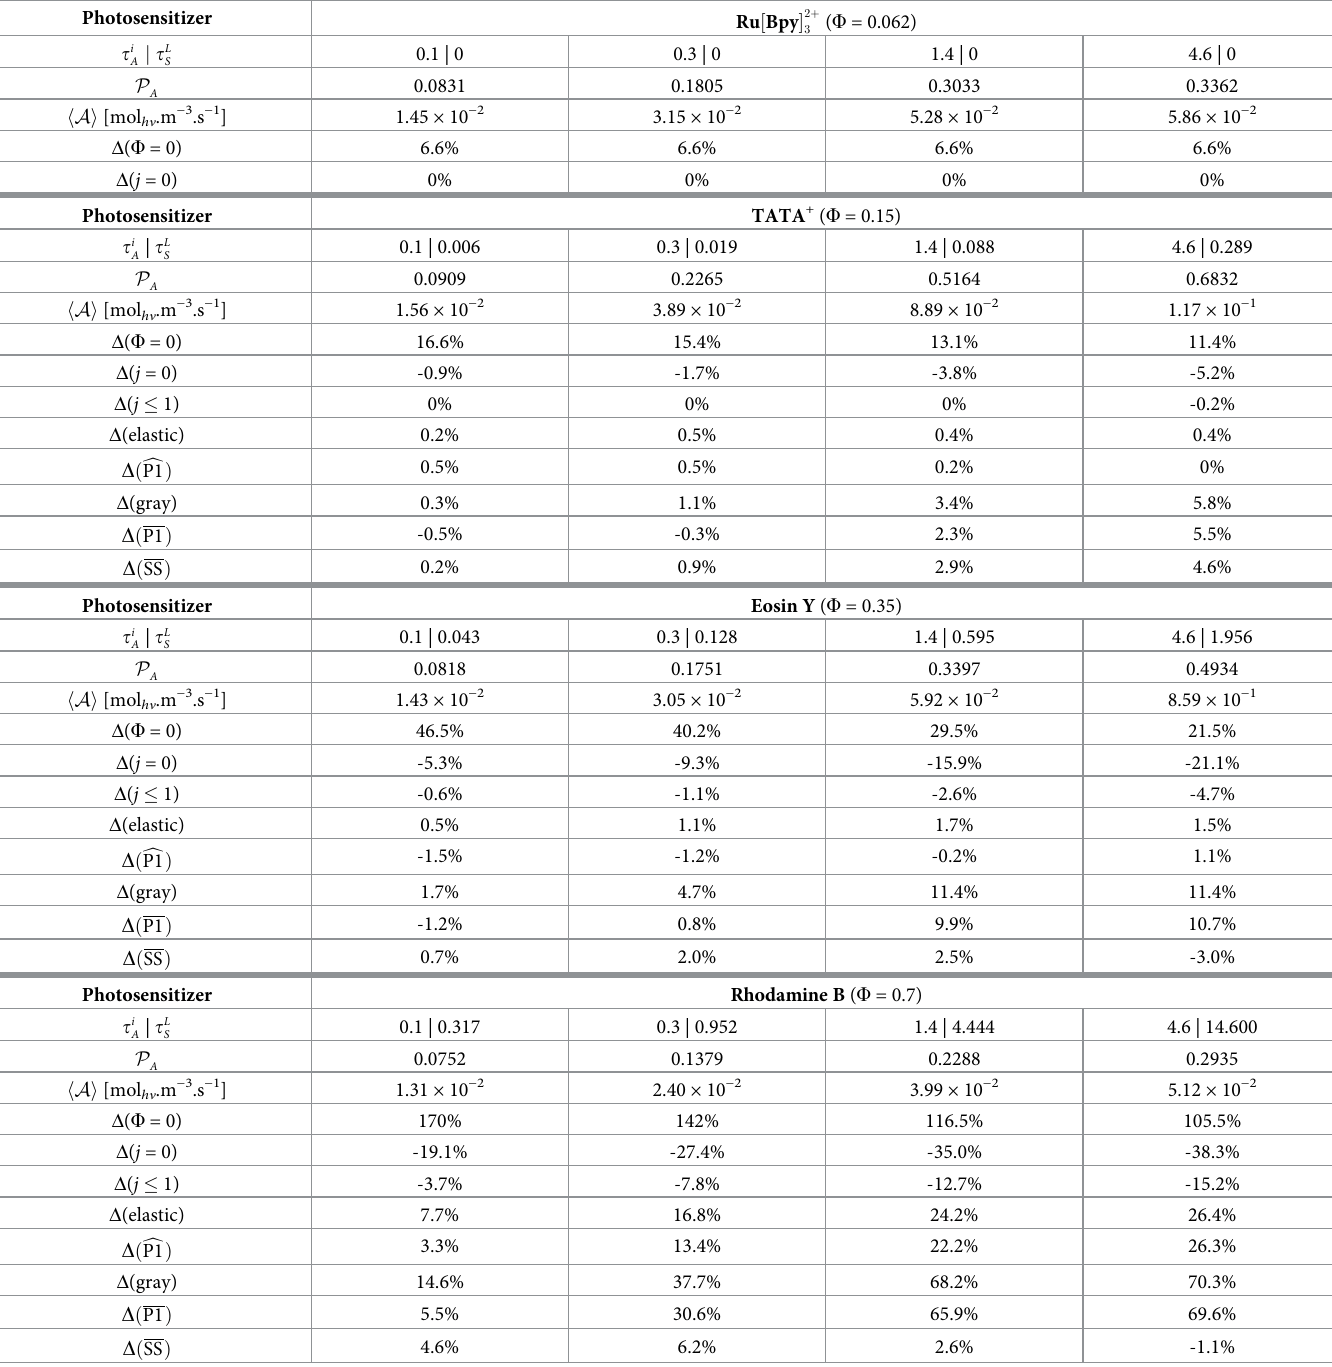
Table 2. Results for Ru ½ Bpy � 2 þ , TATA + , Eosin Y and Rhodamine B photosensitizers (radiative properties are in Fig 2) for the incident solar spectrum in Fig 3, at 3 selected optical thicknesses t i and t L (see Eqs 4–7 and Table 1): Reference absorptance P A S = 1743 μ